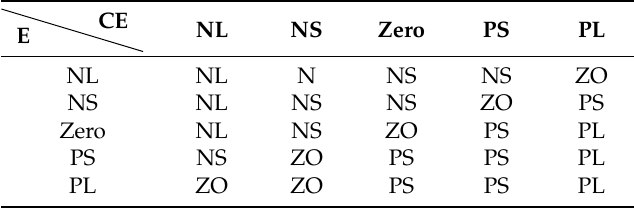
Table 2. The fuzzy rule of ∆ K i